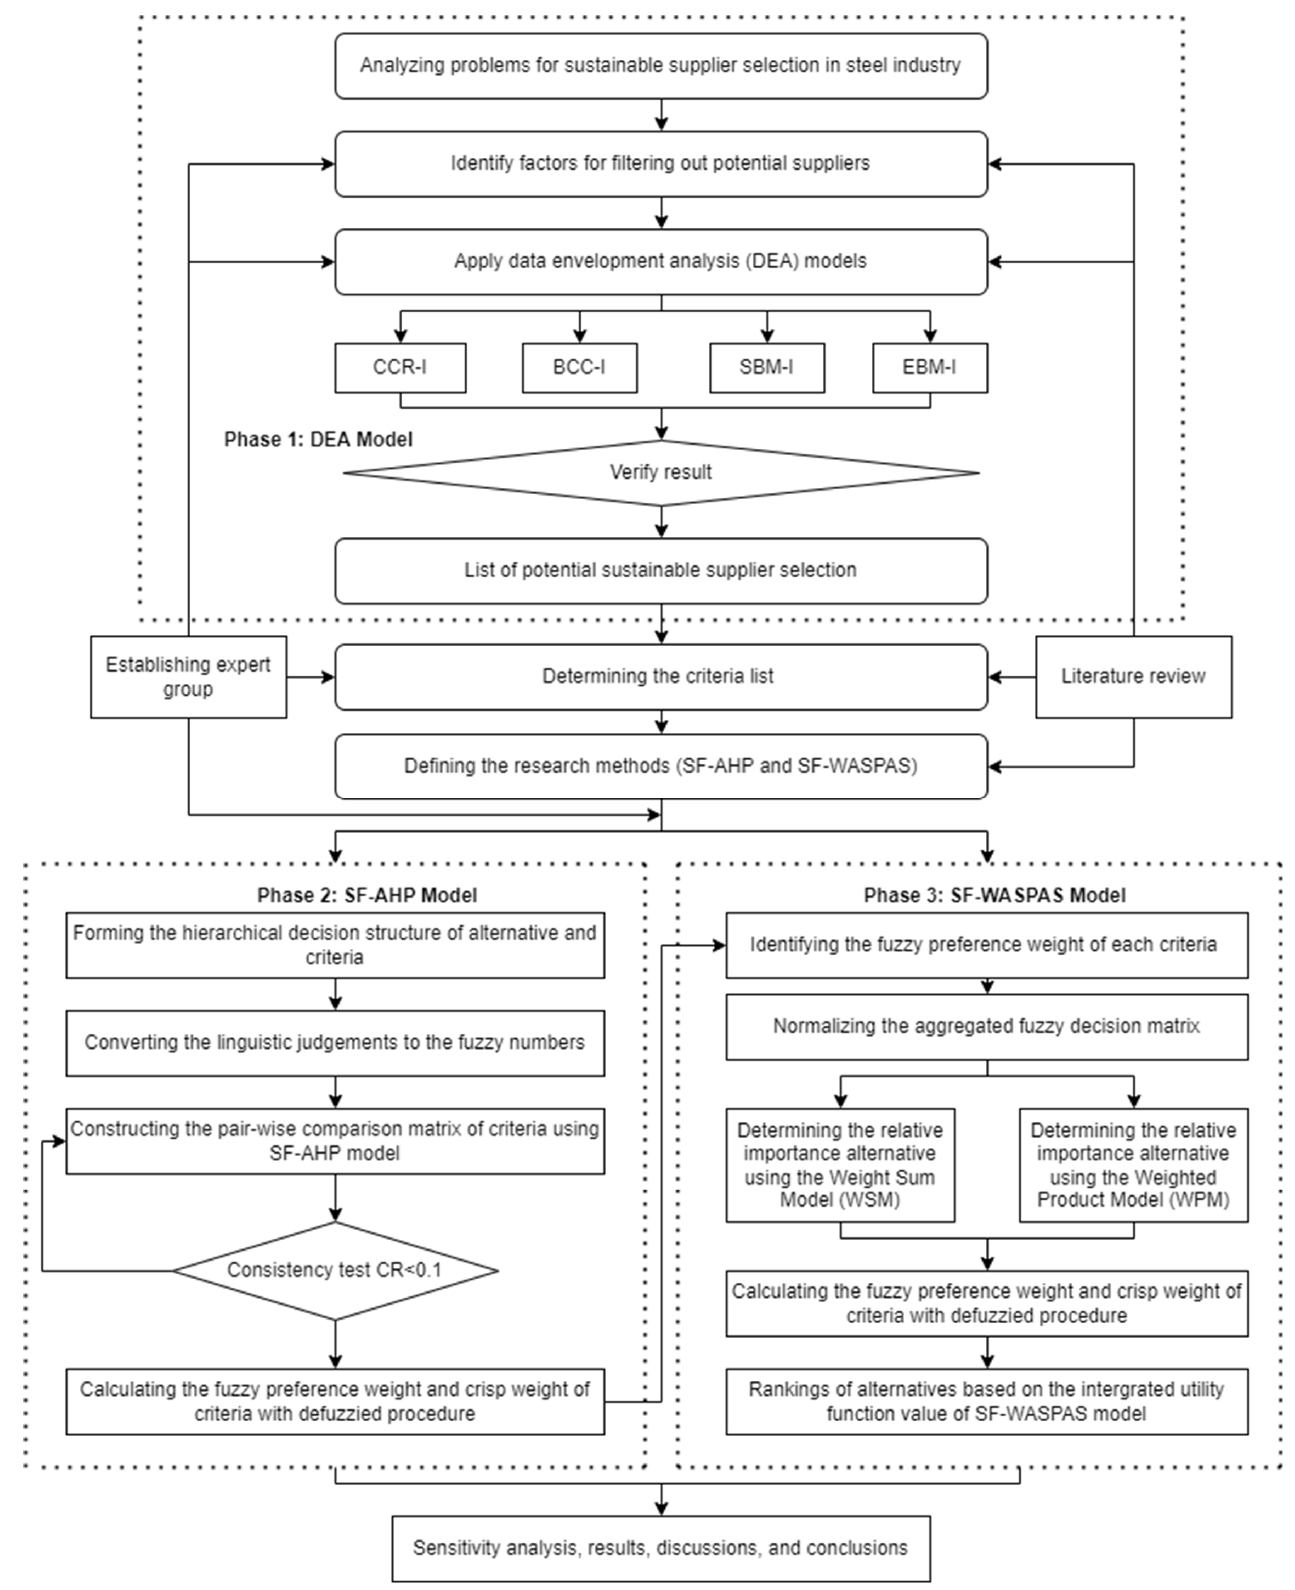
Figure 1. Proposed research framework.